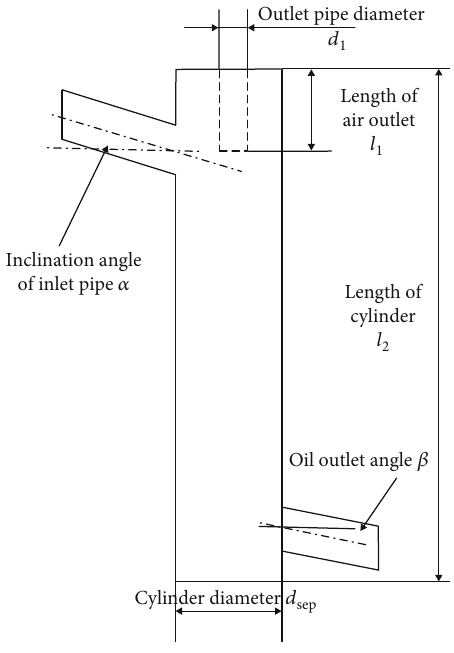
Figure 1: Separator structure